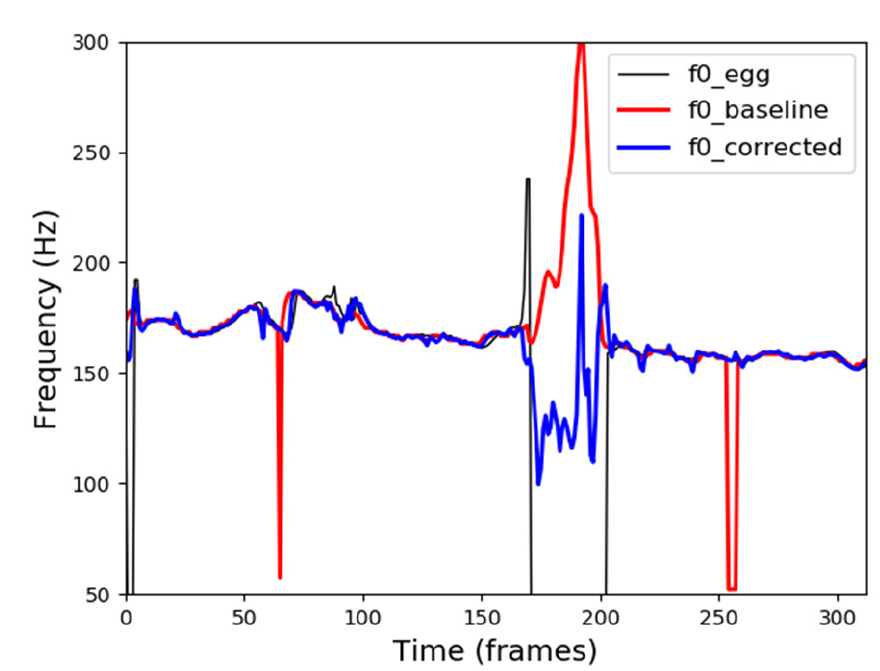
Figure 2. Examples of F0 contours from a female speaker extracted by the baseline, EGG, and corrected methods.